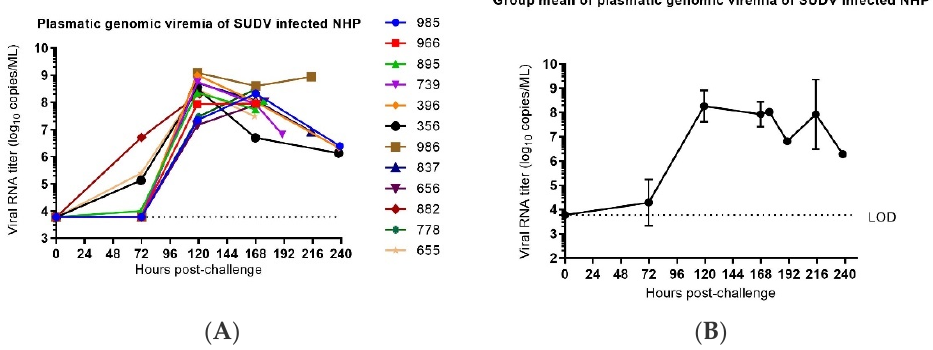
Figure 11. Plasmatic genomic viremia in SUDV-challenged NHPs. ( A ) Plasmatic viral RNA concentration in individual SUDV-challenged animals versus time. vRNA load represents the mean to two titration assay replicates and are expressed in logarithm decimal copies/mL. Time course is expressed in hours post-challenge (pc). LOD is the limit of detection of the PCR assay (=3.78 log 10 copies/mL). ( B ) Group mean ± SD of plasmatic viral RNA versus time. Time course is expressed in days post-challenge (pc).